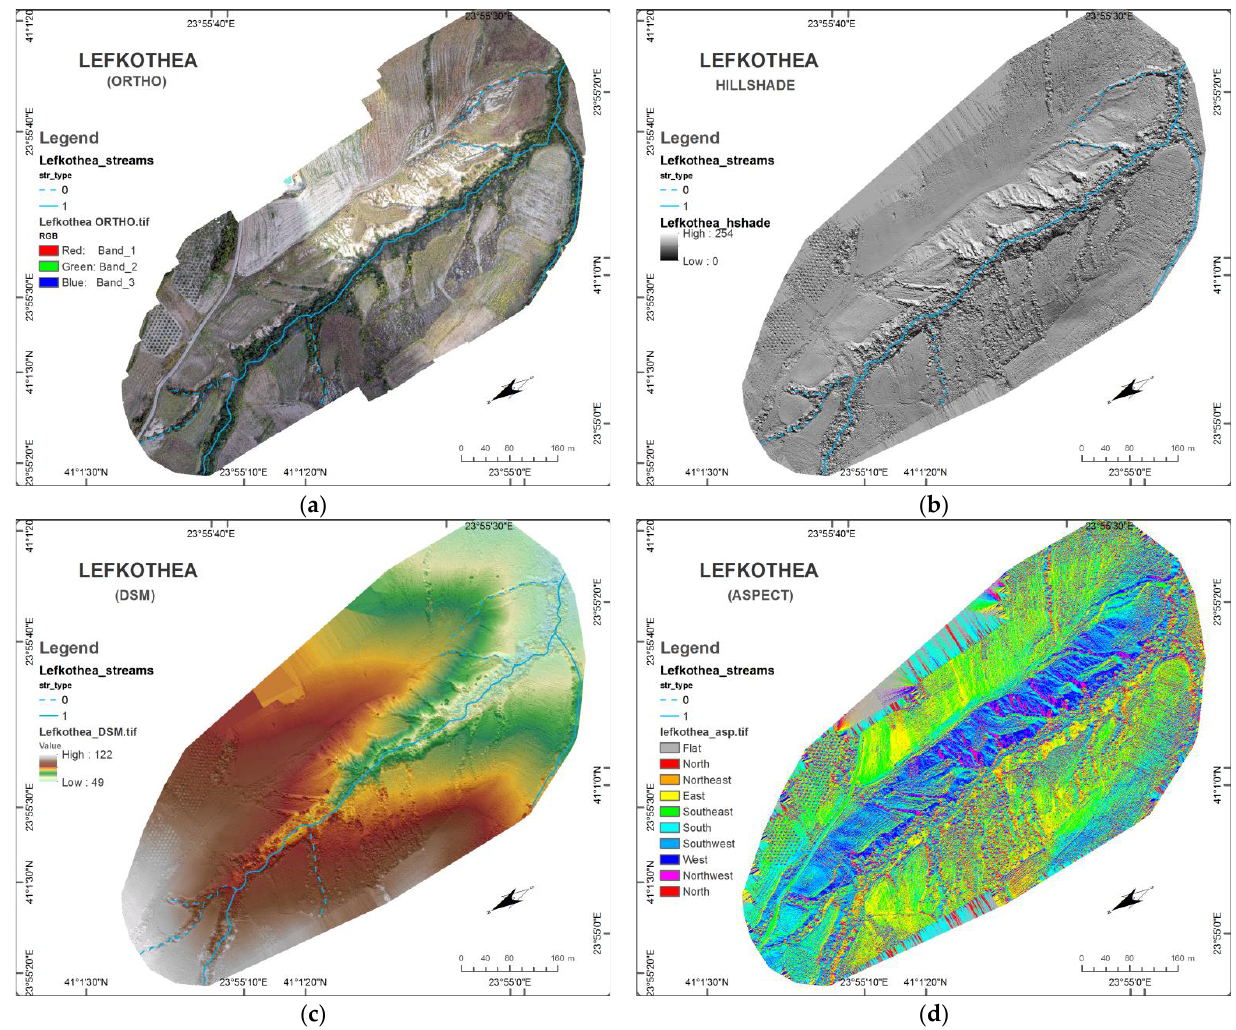
Figure 5. The case study of Lefkothea in Greece captured by the drone flight on 1 September 2022: